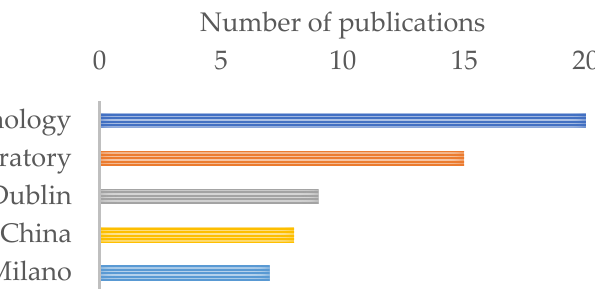
Figure 10. Physics-based urban building energy modeling publications’ affiliated universities.